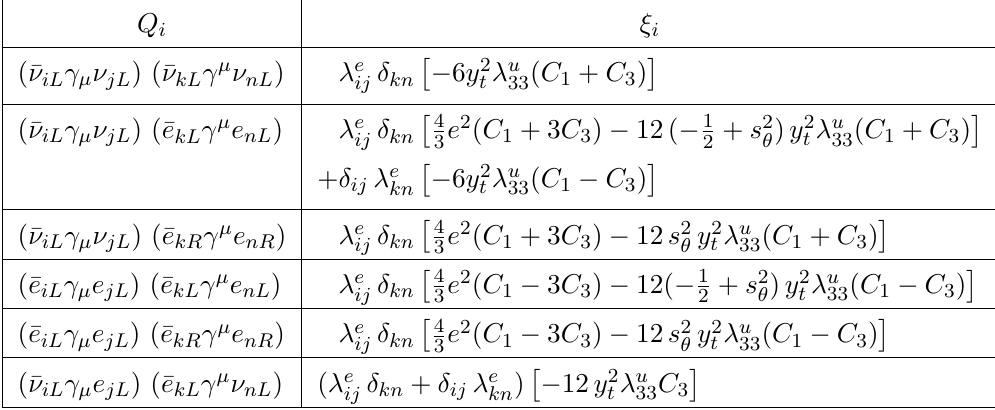
. (cid:18) (cid:25) m , we can drop the last term of eq. (2.38). In this way t EW